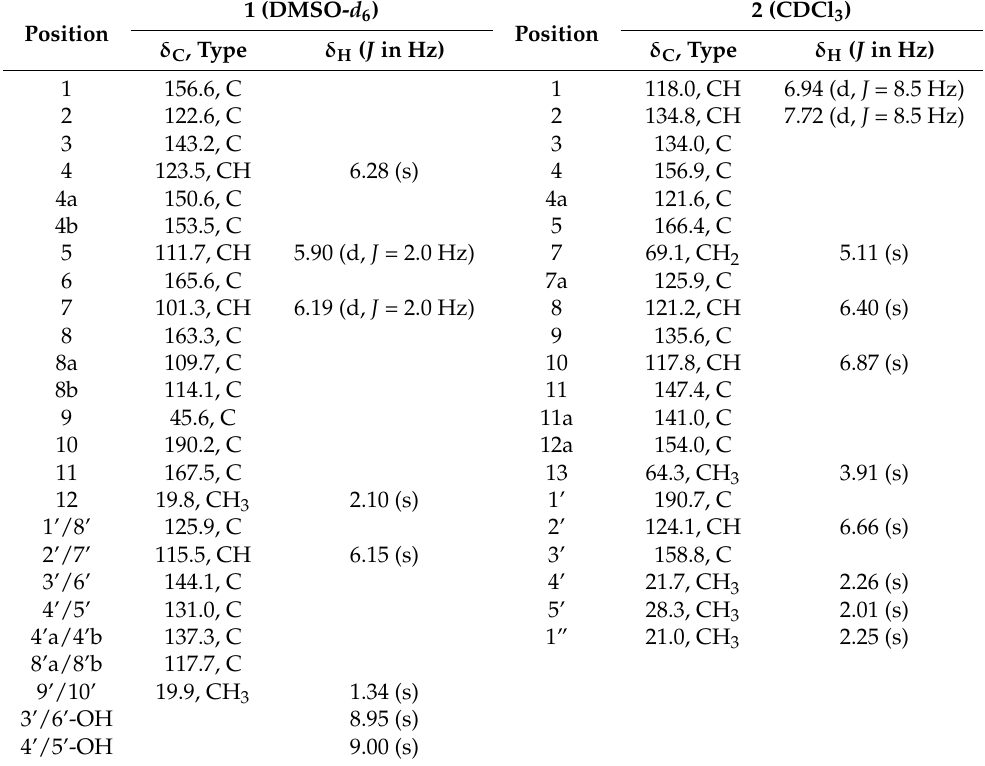
Table 1. 1 H (500 MHz) and 13 C (125 MHz) nuclear magnetic resonance (NMR) data of 1 and 2